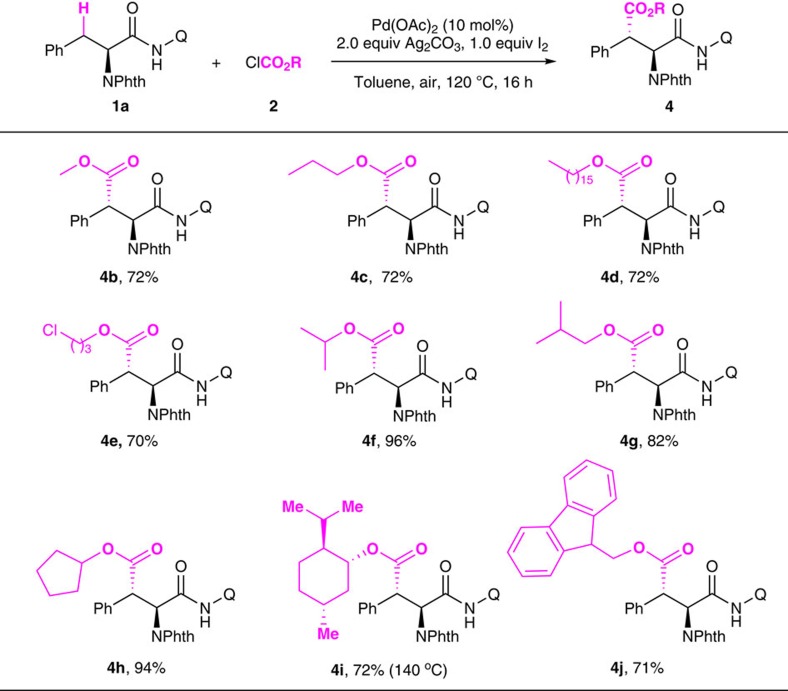
Scope of alkyl chloroformates.Reaction conditions: 1a (0.15 mmol), Pd(OAc)2 (10 mol%), Ag2CO3 (2.0 equiv.), I2 (1.0 equiv.), ClCO2R (3.0 equiv.), toluene (2.0 ml), 120 °C, air, 16 h. Isolated yield.